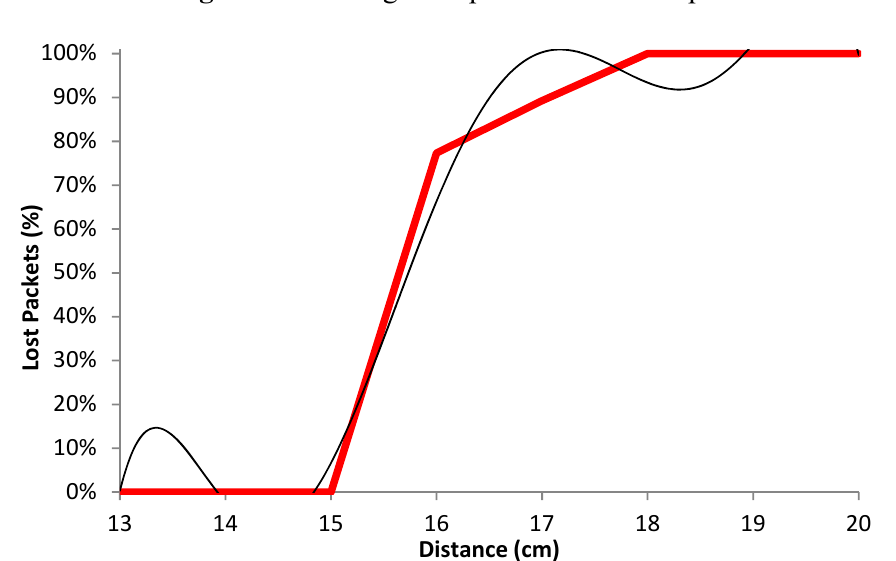
Figure 21. Average lost packets for 11